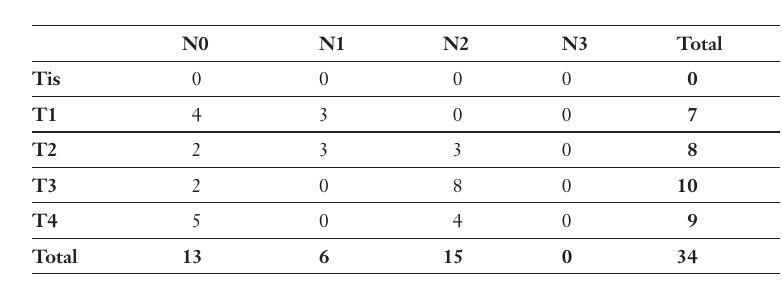
Distribution ofTumor stages according to UICC 2002 classification and status of